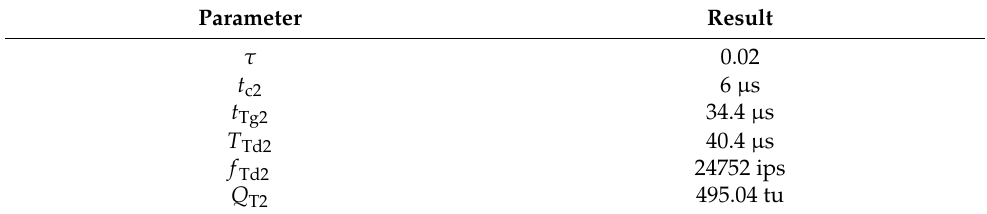
Figure 12. Hyperchaotic system (17) implemented in fixed-point: ( a ) time evolution of states z ( n ) and w ( n ) ; ( b ) phase plane z ( n ) versus w ( n ) . Table 5. Implementation results in fixed-point of the DV of system (17) on the proposed ES.